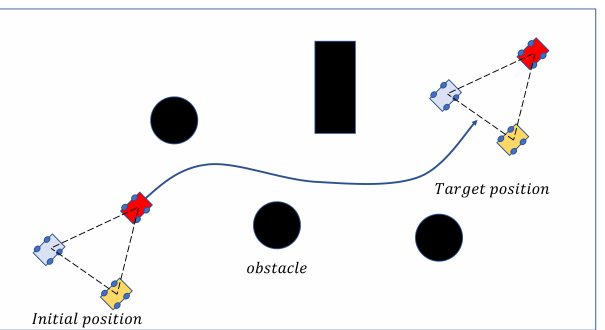
Figure 1. Cooperative control of a formation in an environment with